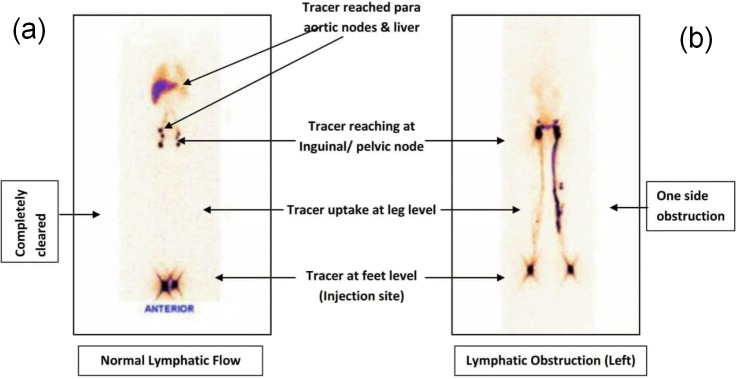
Representative image of whole body lymphatic scan of (a) normal lymphatic flow and (b) lymphatic flow obstruction. These images are given for better understanding of the lymphoscintigraphy imaging made in the study. Subsequent figures (Figs 3–10) are provided as cross sectional images at feet, popliteal and inguino-pelvic label taken at different time points to reflect the change over time.